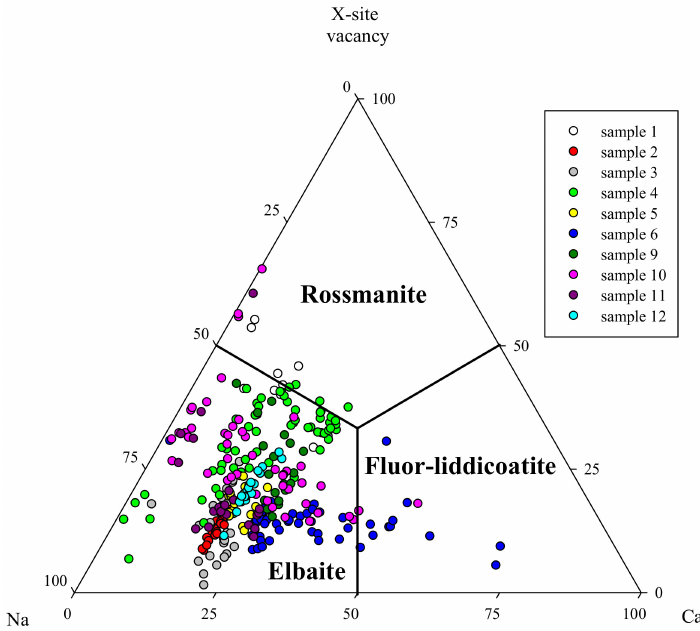
Figure 5. Ternary diagram of X-site composition of all analysed